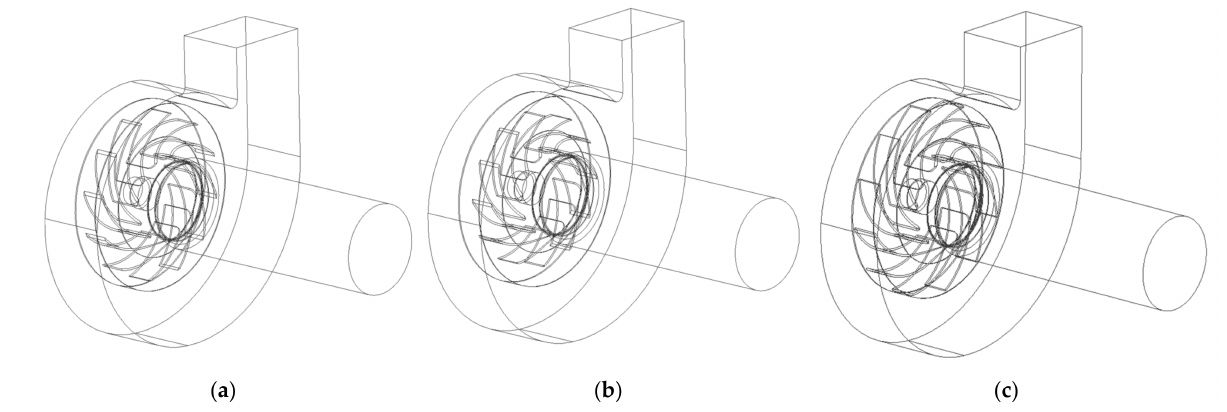
Figure 3. Geometrical model of the flow domain within centrifugal fan with impeller in three different positions: ( a ) middle position of blade; ( b ) minimal position of blade; ( c ) maximal position of